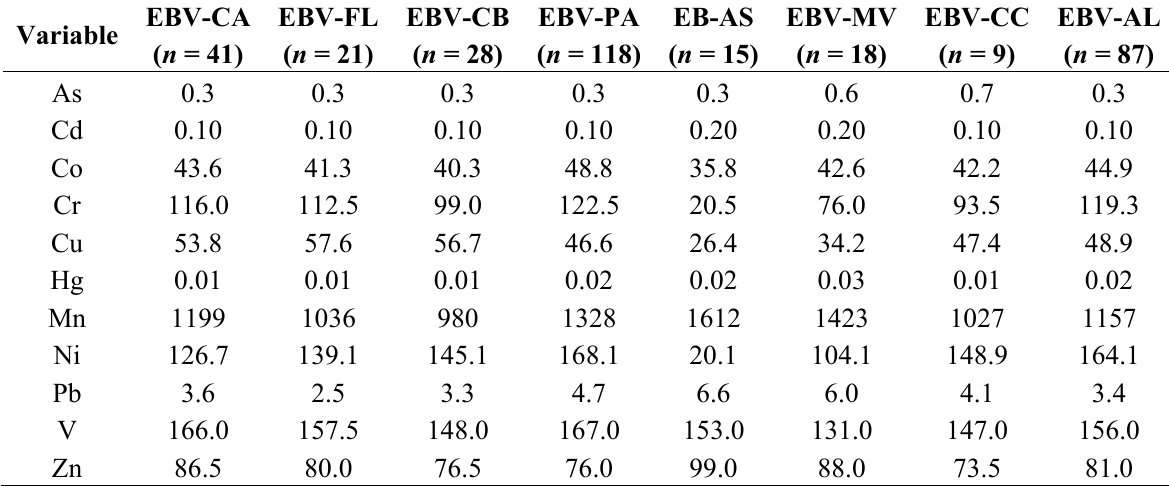
Table 3. Estimated Background Values (EBV-XX) of As, Cd, Co, Cr, Cu, Hg, Mn, Ni, Pb, V, and Zn in the stream sediments of different geological formations in Santiago Island, Cape